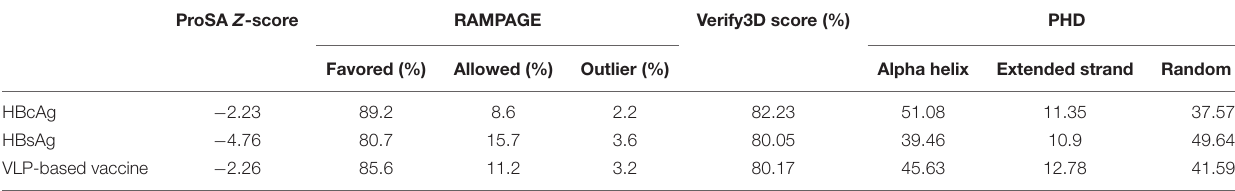
TABLE 1 | Secondary and tertiary structure validations. ProSA Z